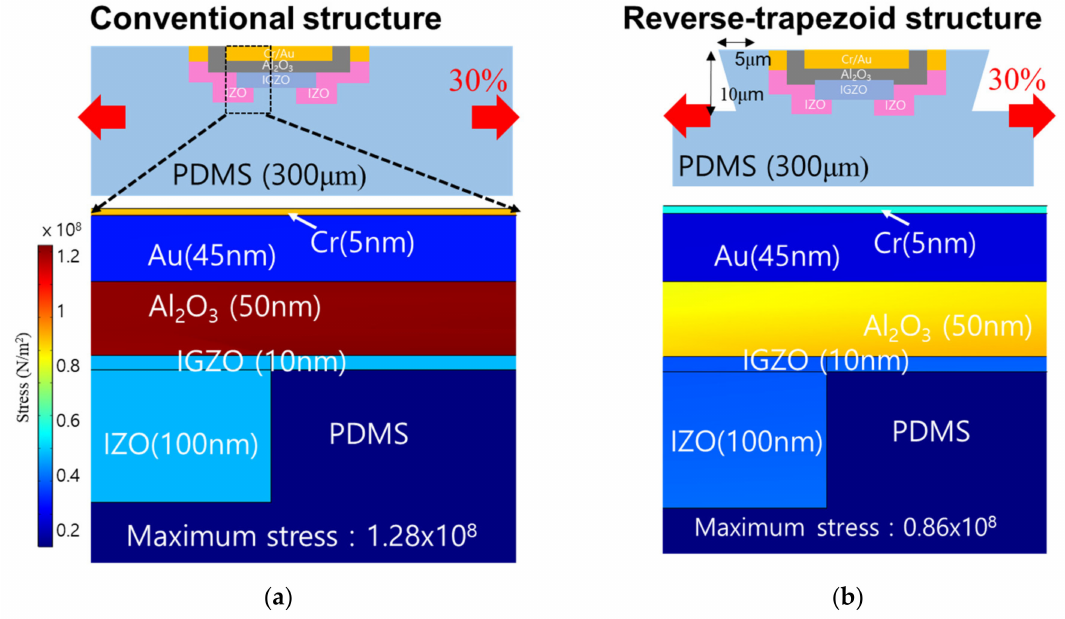
Figure 1. FEA modelling for stretchable a -IGZO TFTs. Stress distributions of a -IGZO TFTs under 30% strain on a PDMS substrate having ( a ) conventional structure and ( b ) reverse-trapezoid structure.